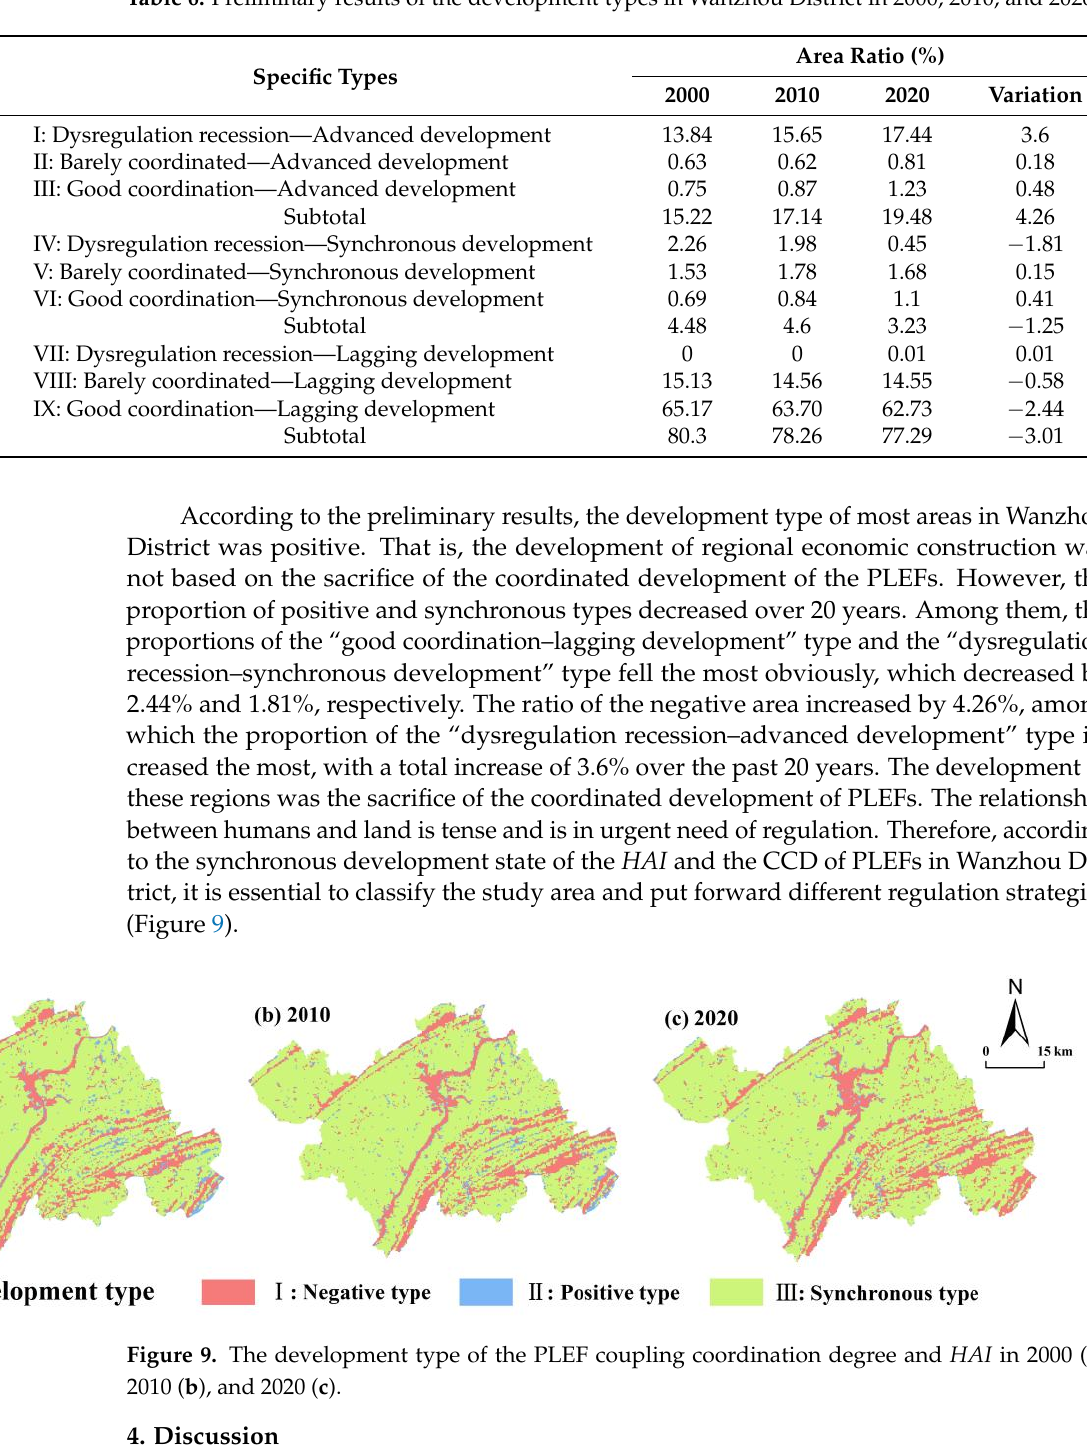
Table 6. Preliminary results of the development types in Wanzhou District in 2000, 2010, and 2020.